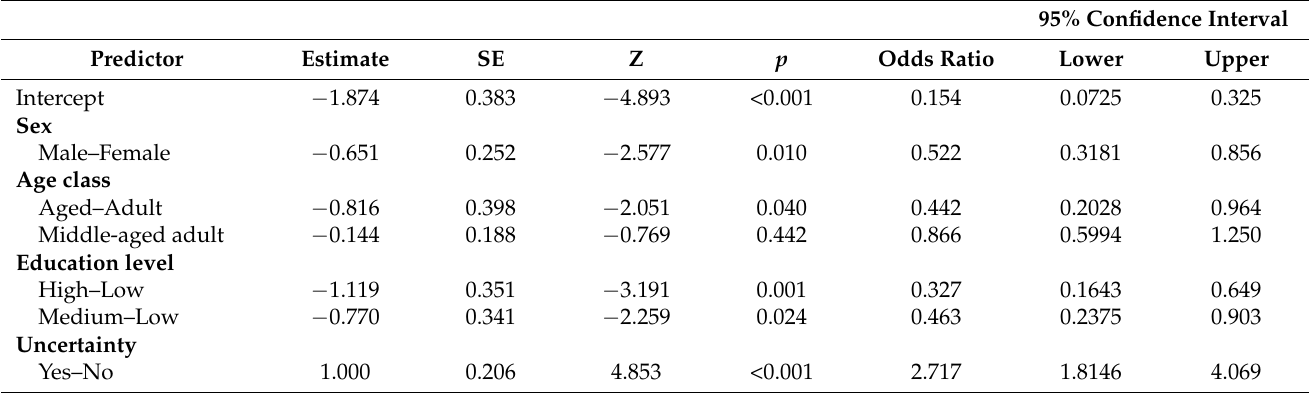
Table A9. Results of Multivariate Regression Analysis Models, with Quality of Sleep as Dependent Variable and Feeling of Uncertainty and Sociodemographic Characteristics as Independent